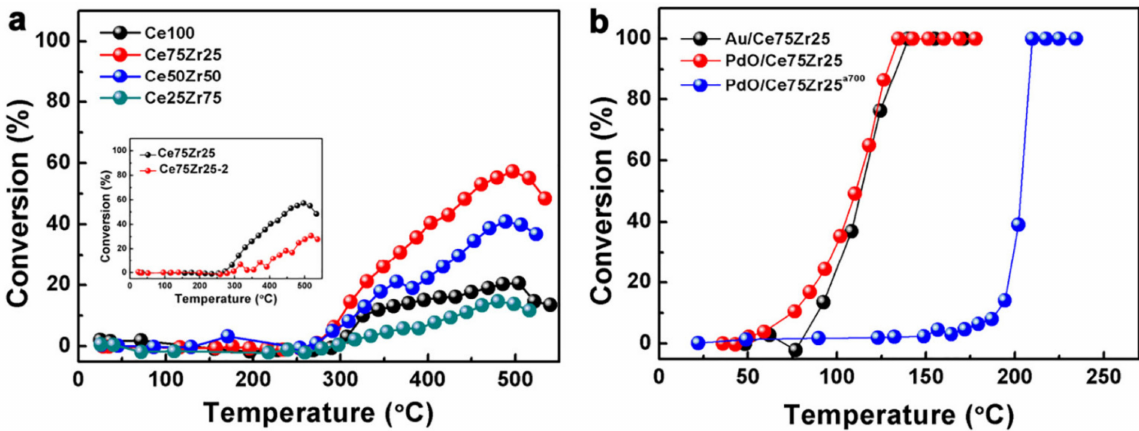
Figure 4. ( a ) Catalytic CO oxidation light-off curves of as-prepared Ce (100 − x) Zr (x) (x = 0, 25, 50, 75) samples. ( b ) Light-off curves of Au/Ce 75-Zr 25, PdO/Ce 75-Zr 25 and PdO/Ce 75-Zr 25 a700 (aged at 700 ◦ C in air for 10 h) (reproduced from Ref.